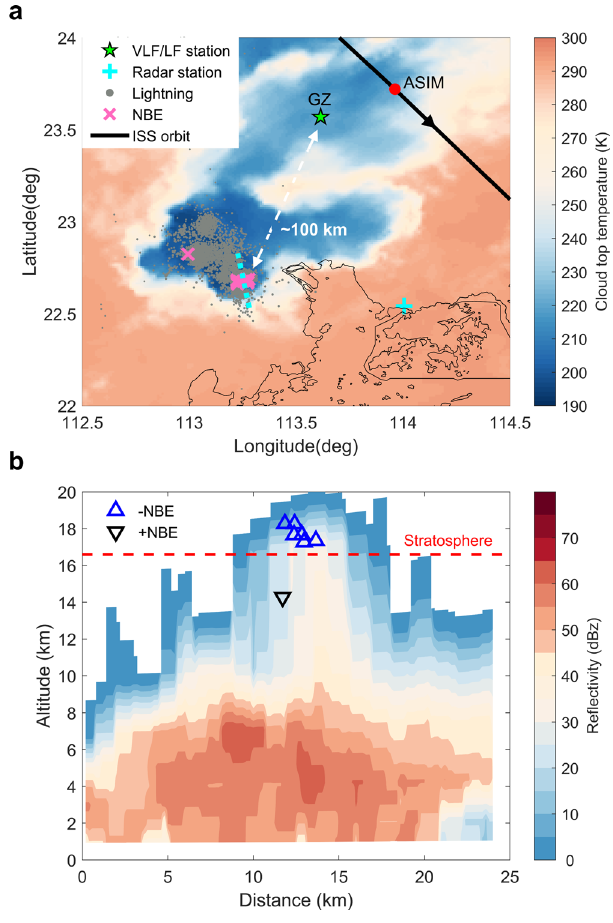
Fig. 1 Meteorological condition of the parent thunderstorm producing both polarities NBEs observed on 7 August 2019. a Cloud top temperatures and lightning locations of the thunderstorm. Color shade represents temperature variations of cloud top. The black line presents the ISS orbit and the red dot represents the ASIM at 13:06:000 UTC. The green ‘ ★ ’ represents the GZ lightning VLF/LF receiver (113.615°E, 23.568°N). The pink ‘ × ’ denotes locations of NBEs. The gray point represents lightning locations obtained from the Vaisala LS7000 lightning location networks. The cyan ‘ + ’ represents the Shenzhen S-band Doppler radar station (114.005°E, 22.542°N). b The vertical pro fi le of the radar re fl ectivity along the dotted cyan line at 13:06 UTC. Color shade presents re fl ectivity variations. The red horizontal line represents the local tropopause height at about 16.6 km obtained from the sounding data. Source data plotted for this fi gure are provided in the Source data fi